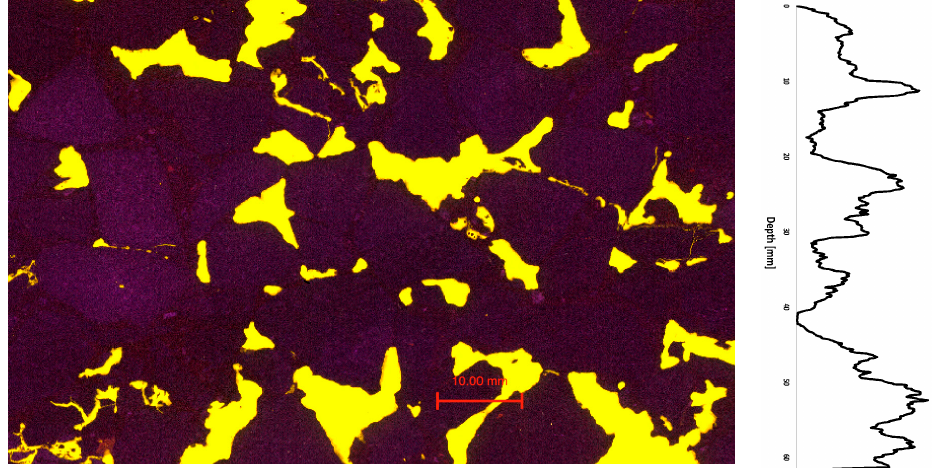
Figure 8. Grinding of porous asphalt (OPA)—asphalt petrology. Recorded scan ( left ) and vertical void distribution ( right ); area: 5.587 mm 2.